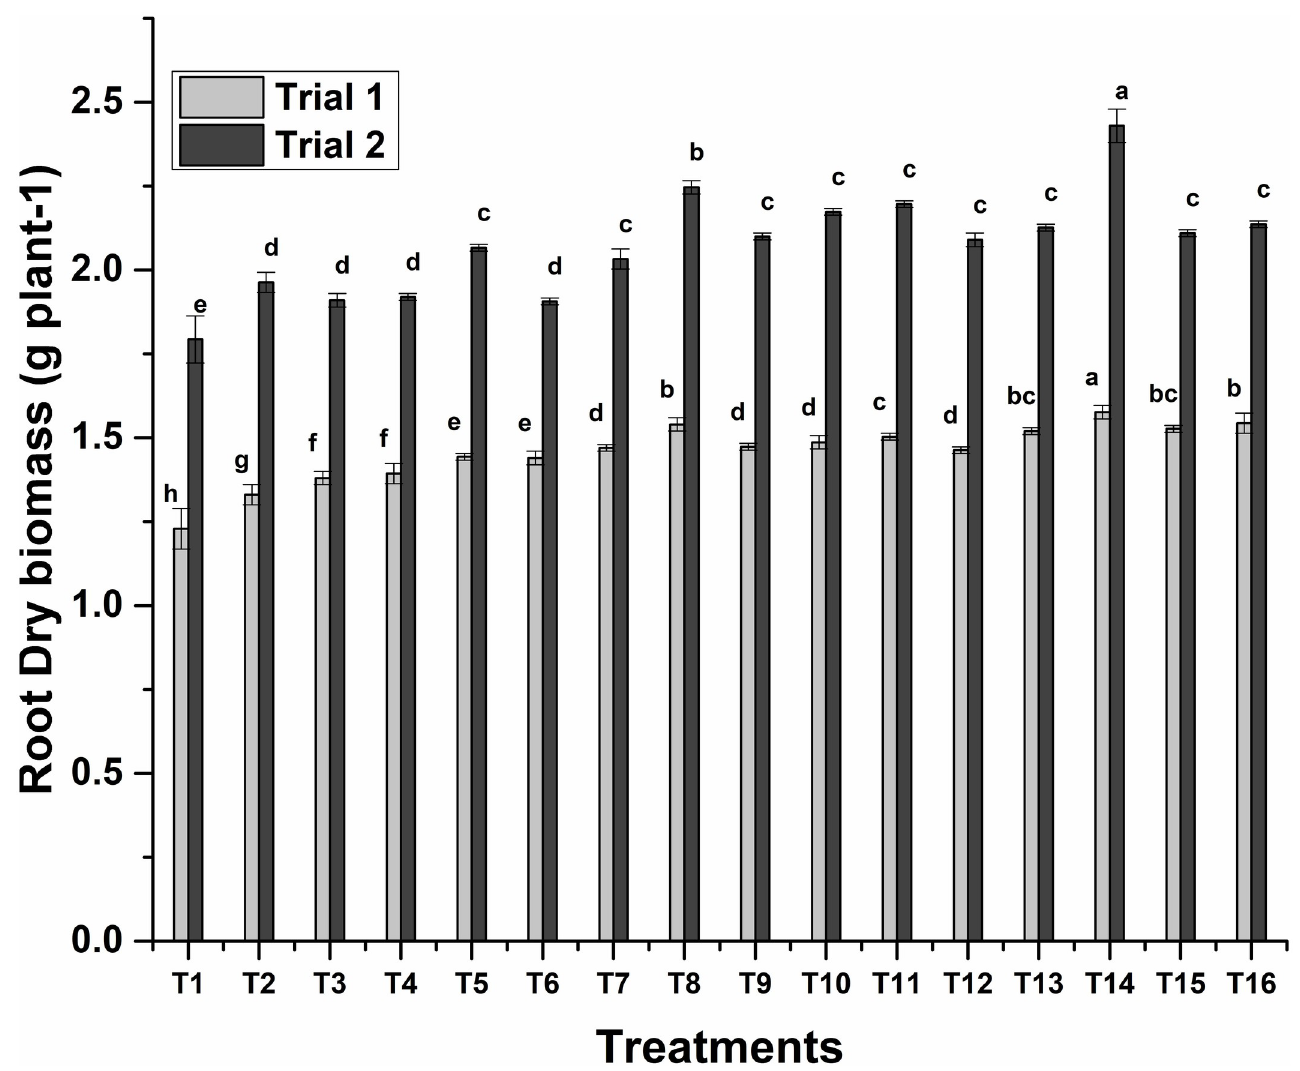
Fig 3. Effects of novel bioinoculants on root dry biomass of wheat in a pot trial. Data are present as a mean of three replicates. Bars sharing same letter(s) are statistically similar ( p � 0 . 05 ). T 1 ; Control, T 2 ; ZM27, T 3 ; ZM31, T 4 ; ZM63, T 5 ; S10, T 6 ; ZM27 + ZM31, T 7 ; ZM27 + ZM63, T 8 ; ZM27 + S10, T 9 ; ZM31 + ZM63, T 10 ; ZM31 + S10, T 11 ; ZM63 + S10, T 12 ; ZM27 + ZM31 + ZM63, T 13 ; ZM27 + ZM31 + S10, T 14 ; ZM27 + ZM63 + S10, T 15 ; ZM31 + ZM63 + S10, T 16 ; ZM27 + ZM31 + ZM63 + S10.